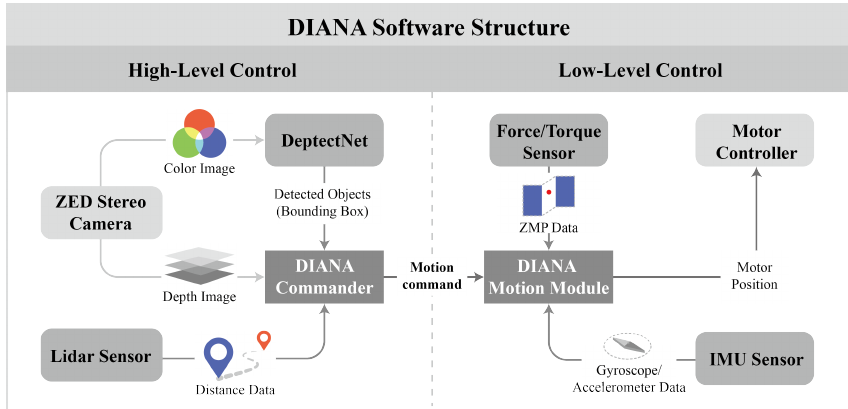
Figure 10. Diagram of DIANA’s software structure.